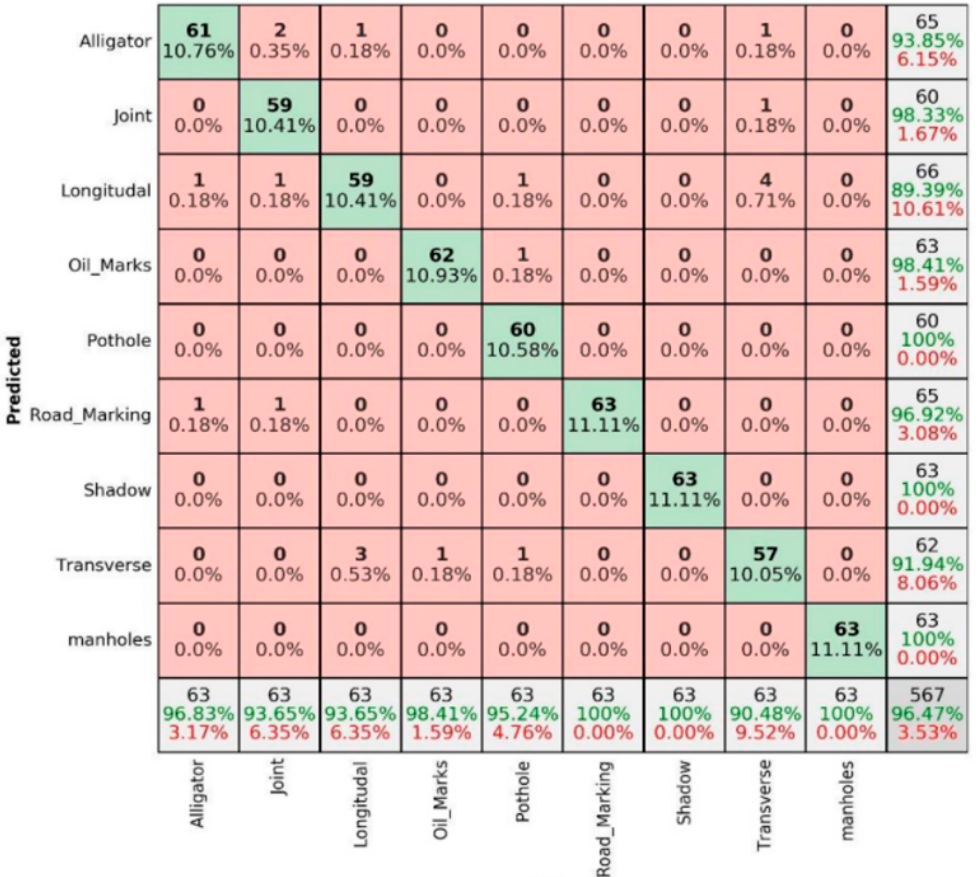
Table 4. Confusion matrix—2 variables (DC alligator used for instance).